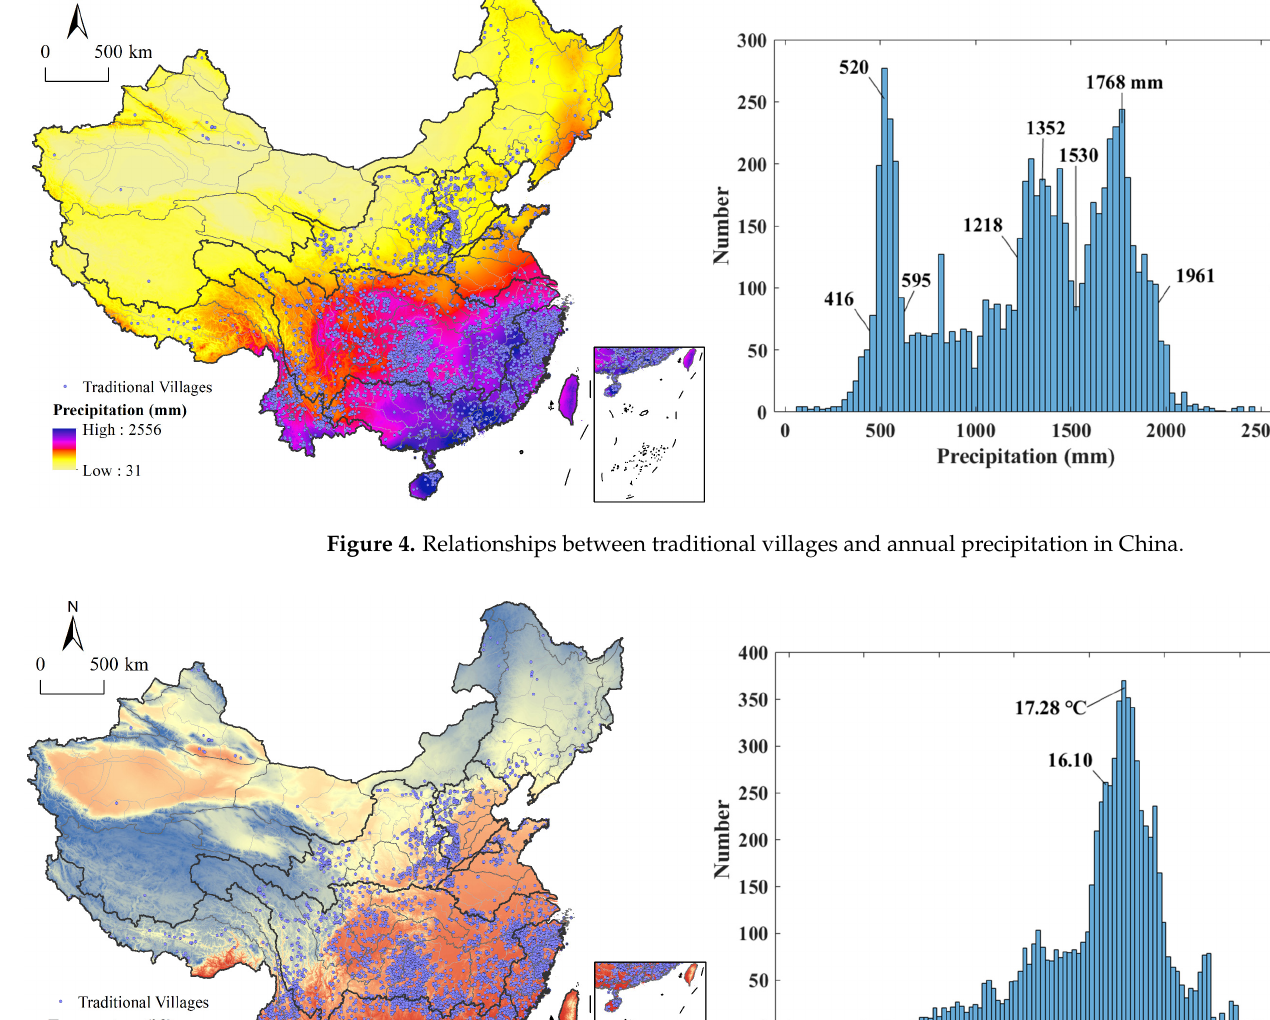
Figure 4. Relationships between traditional villages and annual precipitation in China.